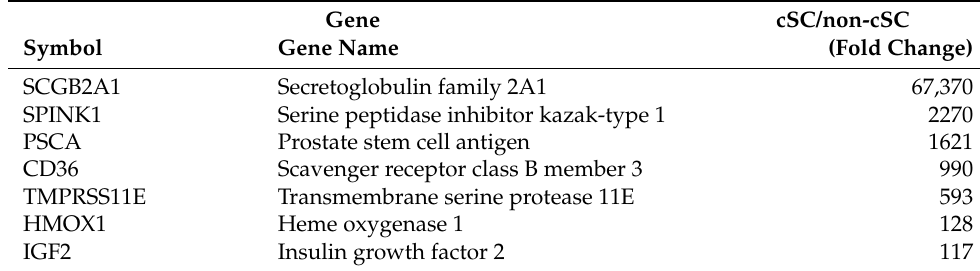
Figure 4. Keratin profiles of differentially expressed keratin genes in non-label retaining prostasphere cells. ( A ) Single-cell RNA-seq of the sorted CFSE Low prostasphere cells with subsequent keratin gene heatmap clustering reveals three subpopulations of progenitor cells: cluster IV (right), cluster V (middle), and cluster VI (left) . Cluster IV is enriched in KRT14, 5, 16, and 6 , indicating a basal progenitor cell lineage. Clusters V and VI are enriched in KRT8, 18, and 10 , indicating a luminal cell lineage. ( B ) TSCAN analysis of KRT8 and KRT18 in CFSE Low cells suggests a relationship between cluster V (2) and VI (1), but not cluster IV (3). Relative gene expression levels are noted numerically for each cluster. Table 1. Top genes enriched in prostate cancer stem-like